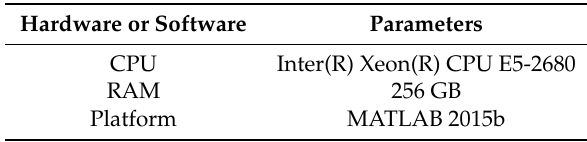
Table 6. The Simulation